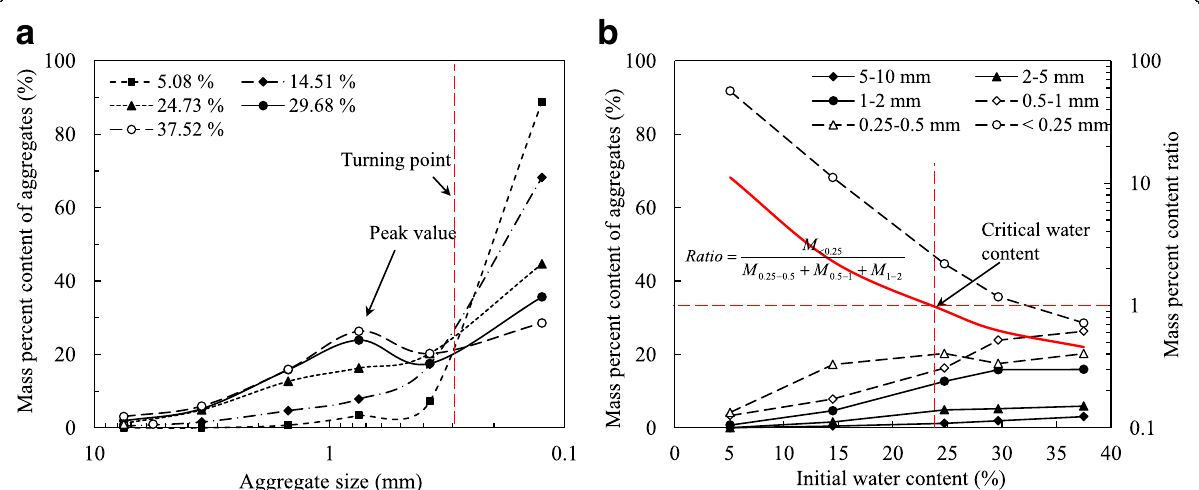
Fig. 7 ( a ) Size distribution of water – stable aggregates with different initial water content; ( b ) Mass percent content of soil aggregates in each size range